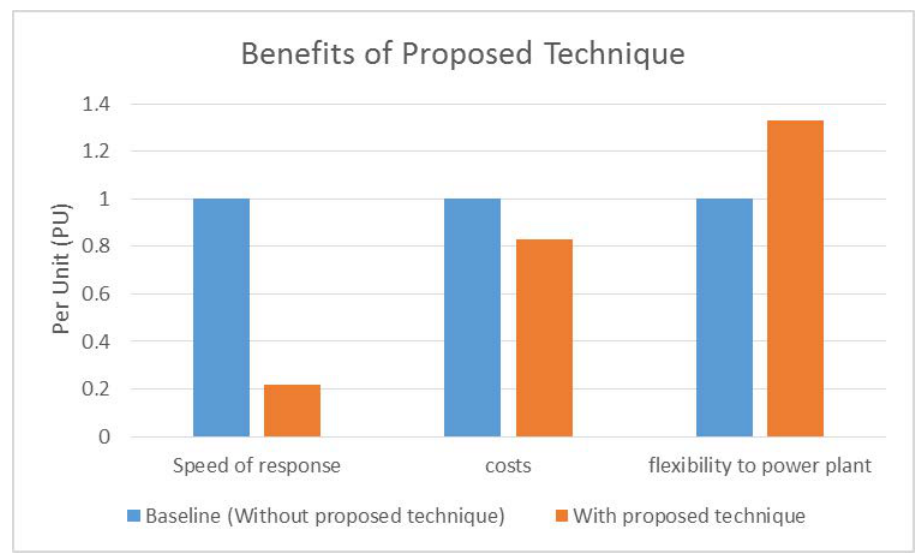
Figure 3. Benefits of Aggregation strategy.